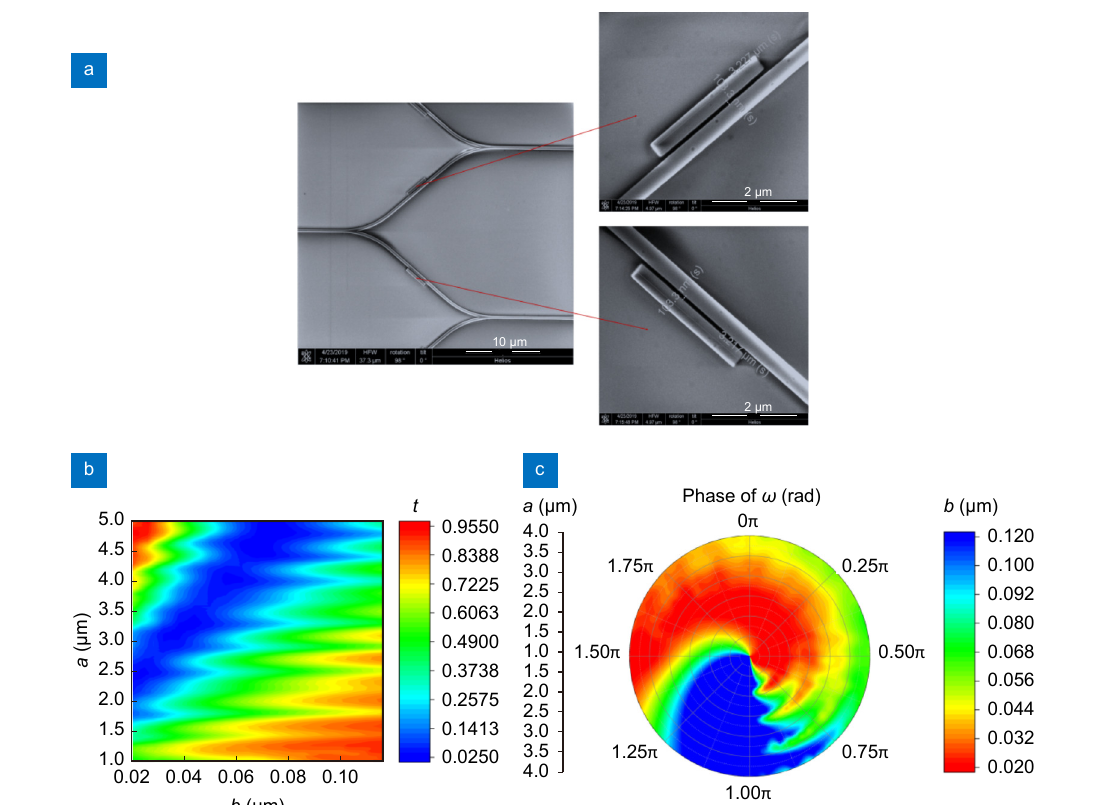
Fig. 2 | Weight regulation. ( a ) SEM image of Y-shaped waveguides side-coupled silicon weight modulators. Two arms of the “Y” structure wave- guide correspond to two kinds of weights. By regulating the length a of weight modulator and the gap width b between two waveguides: ( b ) The magnitude of weight ω can be continuously adjusted from 0.03 to 0.95. ( c ) The phase of weight ω can be continuously adjusted from 0 to 2 π